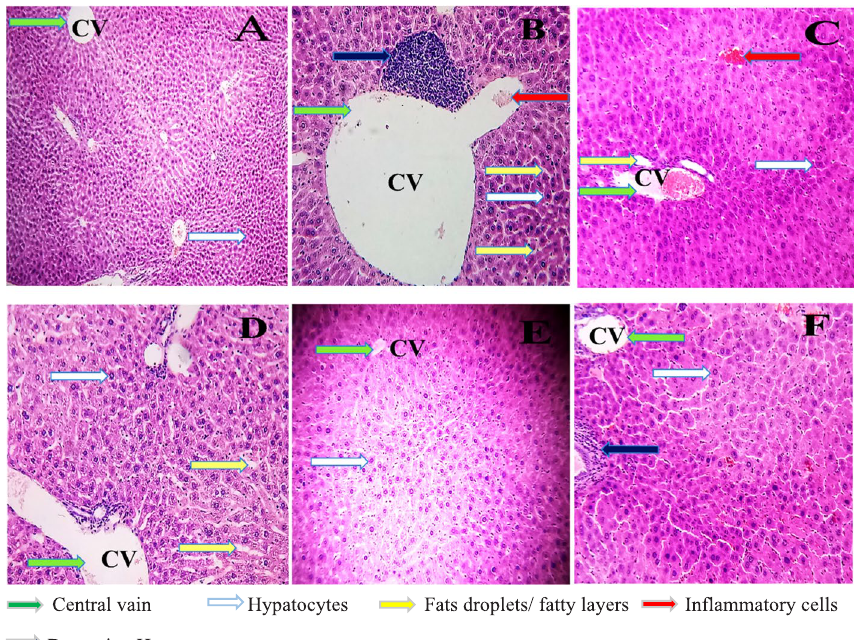
Fig. 1 The Potentiality of Melastoma malabathricum extracts to protect the liver in HCD mice. a Normal group: Demonstrated no fat accumulation and hepatocytes enlargement (gray arrow). b Hyperlipidemic control: Exhibited prominently amassed micro fatty layers (yellow allow), enlarged hepatocytes (gray arrow), and cellular damaging (blue arrow) surrounding the central vein (CV) (green arrow) but also noticed the presence of inflammatory cells in the CV (red arrow). c MFA-500 mg/kg: Deposition of fat droplets among the intercellular space (yellow arrow), inflammatory cells infiltration (red allow), and, a little bit larger hepatocytes were also observed (gray arrow). d MSE-250 mg/kg: Fat granules hoarded among the intercellular space (yellow arrow) and hepatocyte enlargement (gray arrow) also occurred around CV. e MSE-500 mg/kg: Cellular infrastructure was almost the same as a normal control group, with no fat globules or fatty layer found in the liver. f ATOVAT-20 mg/kg: Seemingly no sign of deposited fats but a bit of cellular deformation (blue arrow) observed like as group D. (Pictures magnification